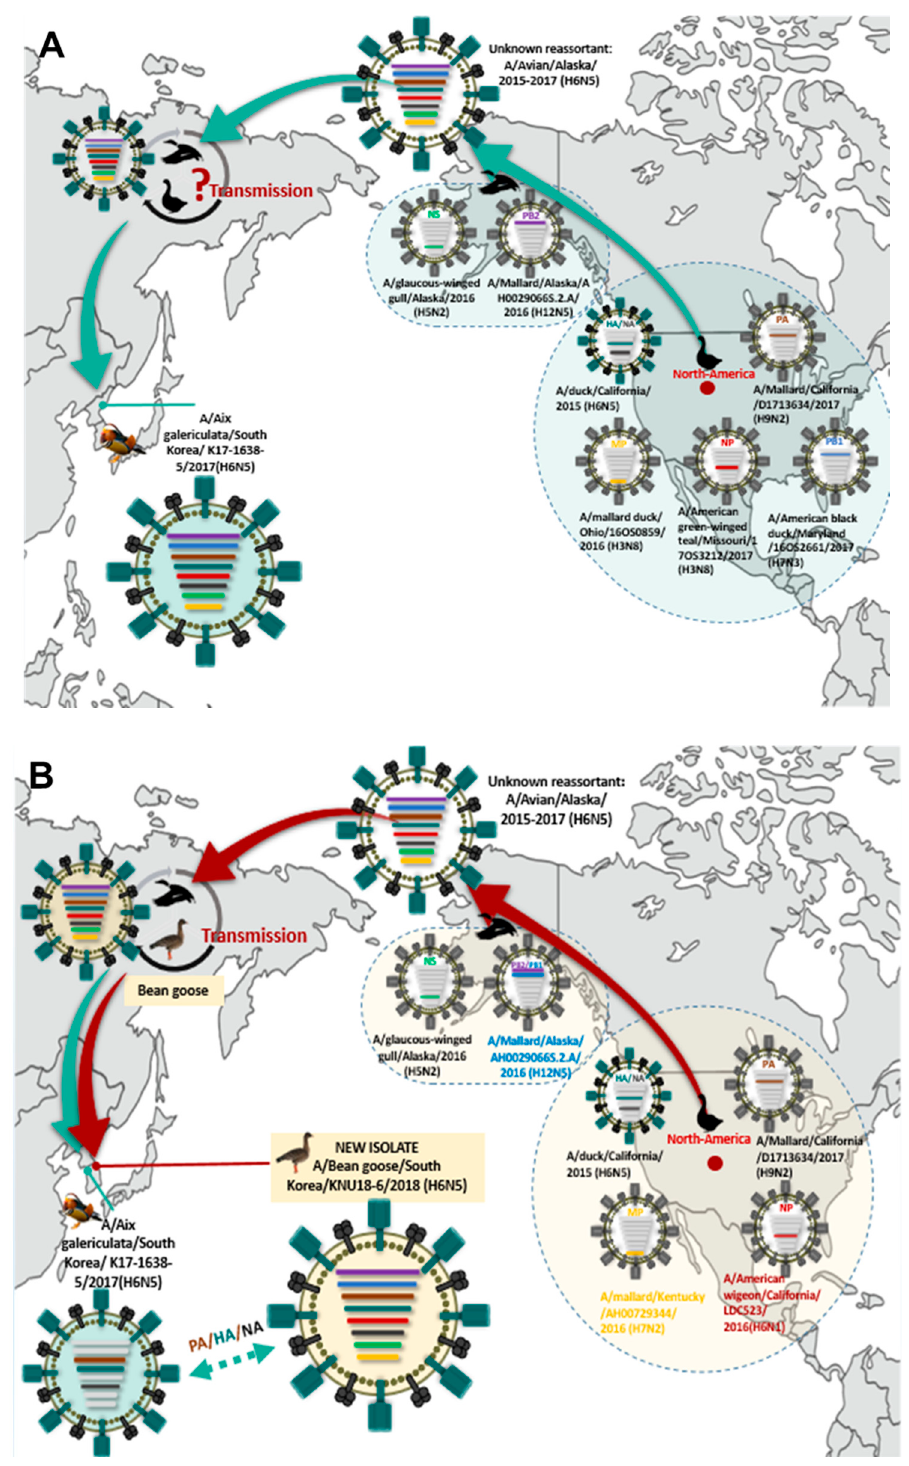
Figure 5. Evolutionary hypothesis for the ancestor of each gene segment of A / Aix galericulata / South Korea / K17-1638-5 / 2017(H6N5) ( A ) and A / Bean goose / South Korea / KNU18-6 / 2018(H6N5) ( B ).